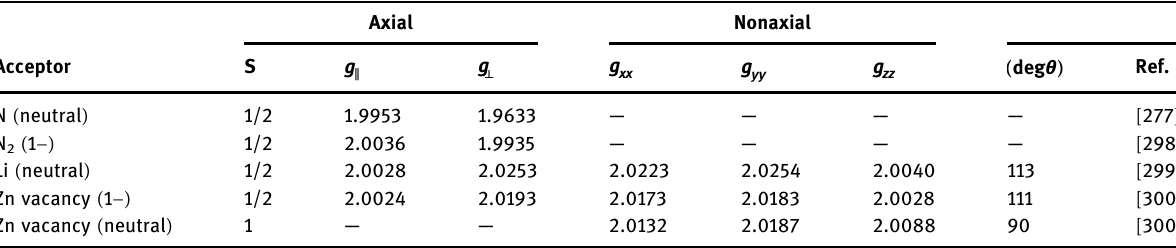
Table 3: EPR parameters for acceptors in ZnO